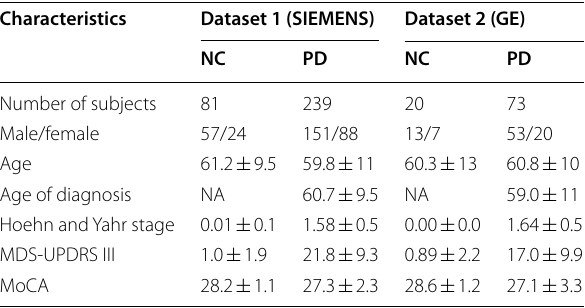
MDS-UPDRS movement disorder society-unified Parkinson’s disease rating scale, MoCA Montreal Cognitive Assessment, NC normal control, PD Parkinson’s disease, NA not applicable